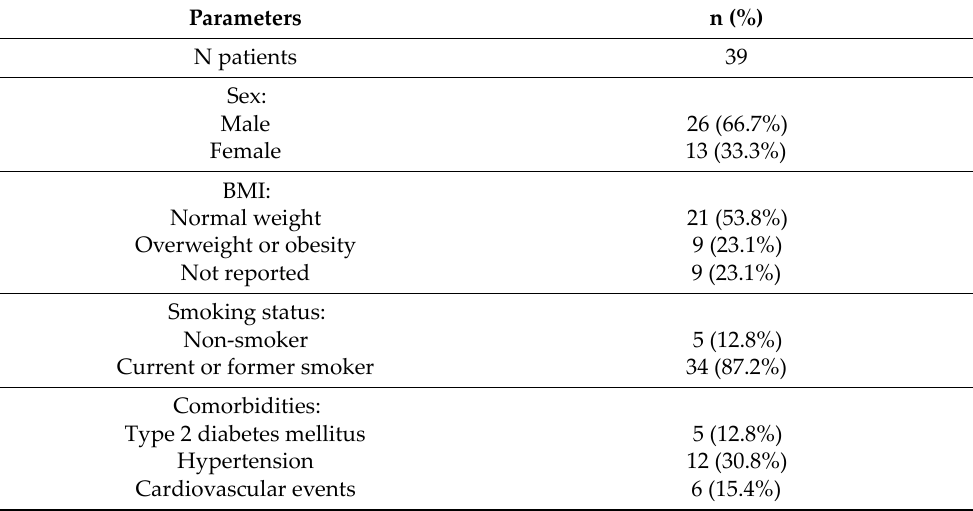
Table 2. Clinical and pathological characteristics of patients and type of